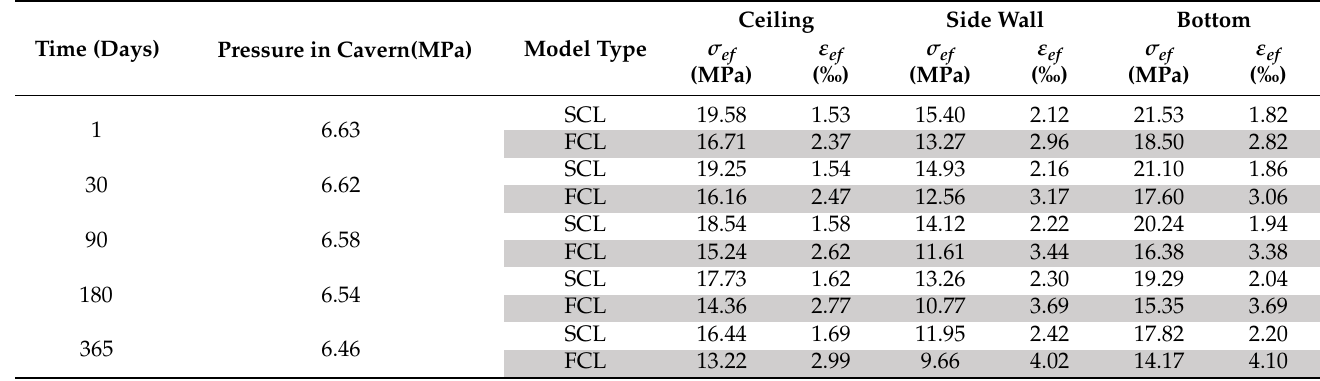
Table 9. Strength criteria for the two salt-creep models. Status at the end of a given work cycle (after 8 h of cavern rest at maximum